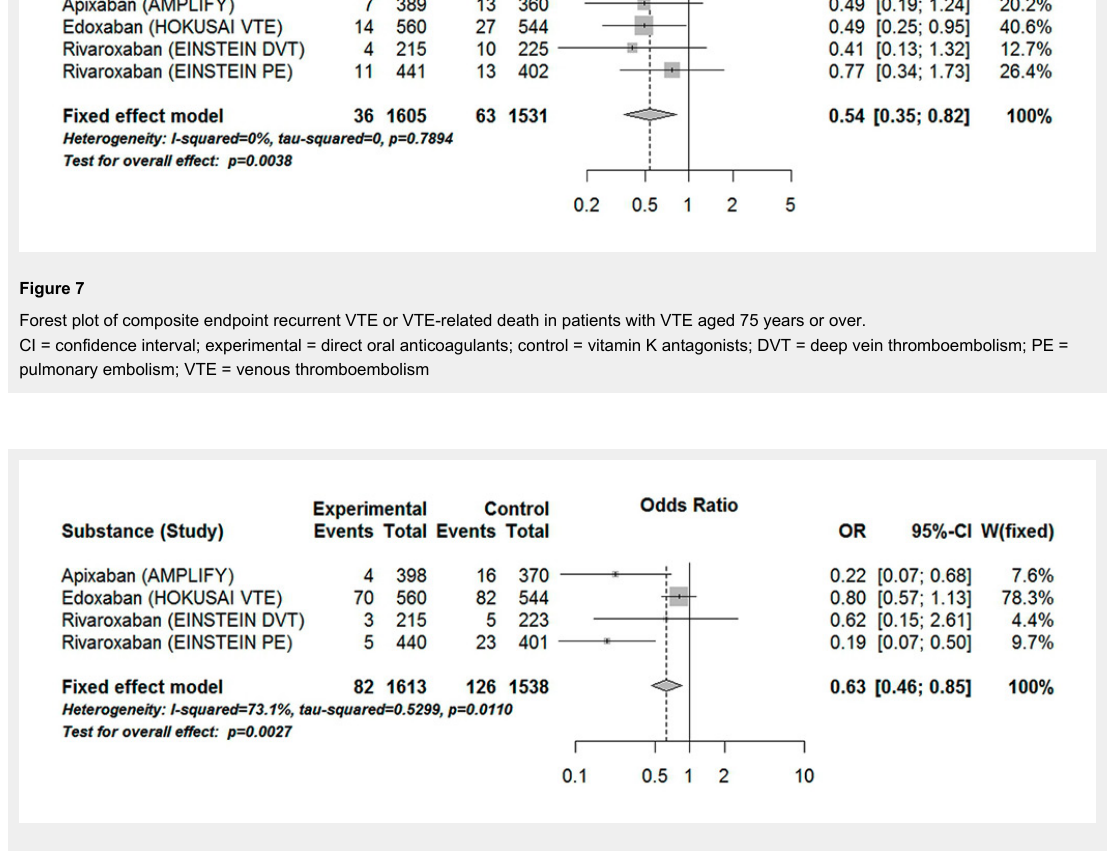
Figure 8 Forest plot of composite safety endpoint major bleeding and clinically significant non-major bleeding in patients with VTE aged 75 years or over. CI = confidence interval; experimental = direct oral anticoagulants; control = vitamin K